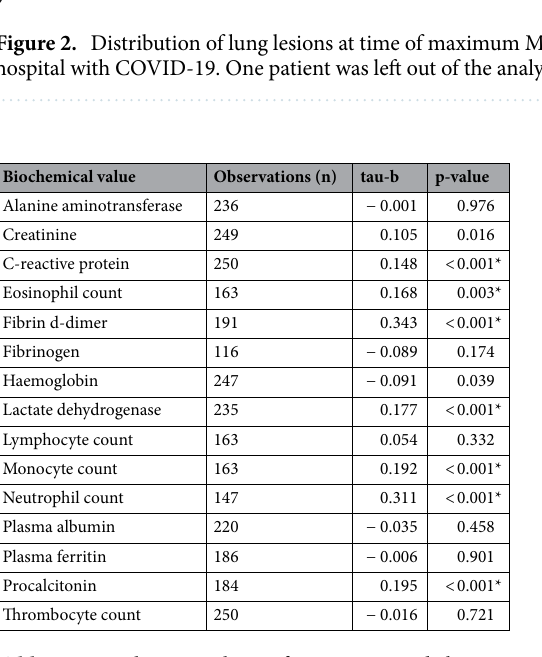
Table 2. Correlation analyses of MBrixia scored chest x-ray images and 15 time-matched biochemical values. *Statistically significant (p-value < 0.0033).